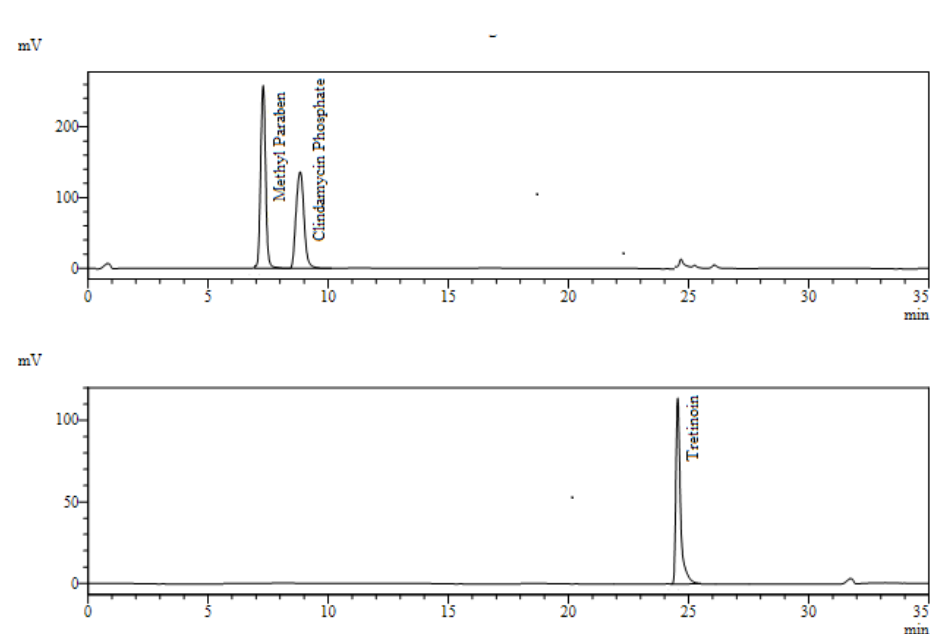
Figure 7. HPLC chromatogram of Cleret Gel analysis. Peaks: methyl paraben, t R ∼ 7.3 min; clindamycin phosphate, t R ∼ 8.9 min; tretinoin, t R ∼ 24.8 min.